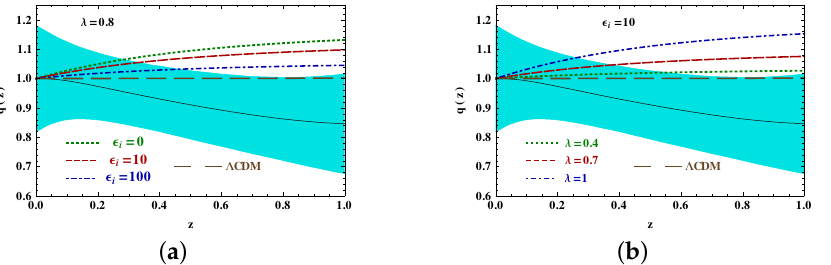
Figure 4. Evolution of q ( z ) has been shown. The shaded region is the 1 σ uncertainty in the recon- structed q ( z ) from the Pantheon data set of SNIa [73]. The brown (long-dashed) line represents q ( z ) for Λ CDM. For both the figures Ω m0 = 0.3. ( a ) Green (dotted), red (dashed), and blue (dot-dashed) curves correspond to (cid:101) i = 0, 10, 100 respectively for the exponential potential with slope λ = 0.8; ( b ) Green (dotted), red (dashed), and blue (dot dashed) curves correspond to λ = 0.4, 0.7, and 1 respectively. We have kept (cid:101) i =